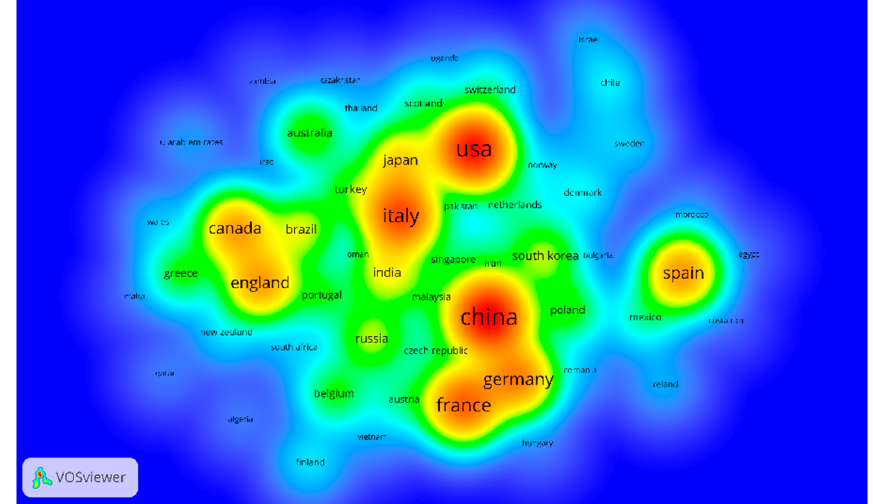
Figure 3. Country coauthoring network density knowledge map.